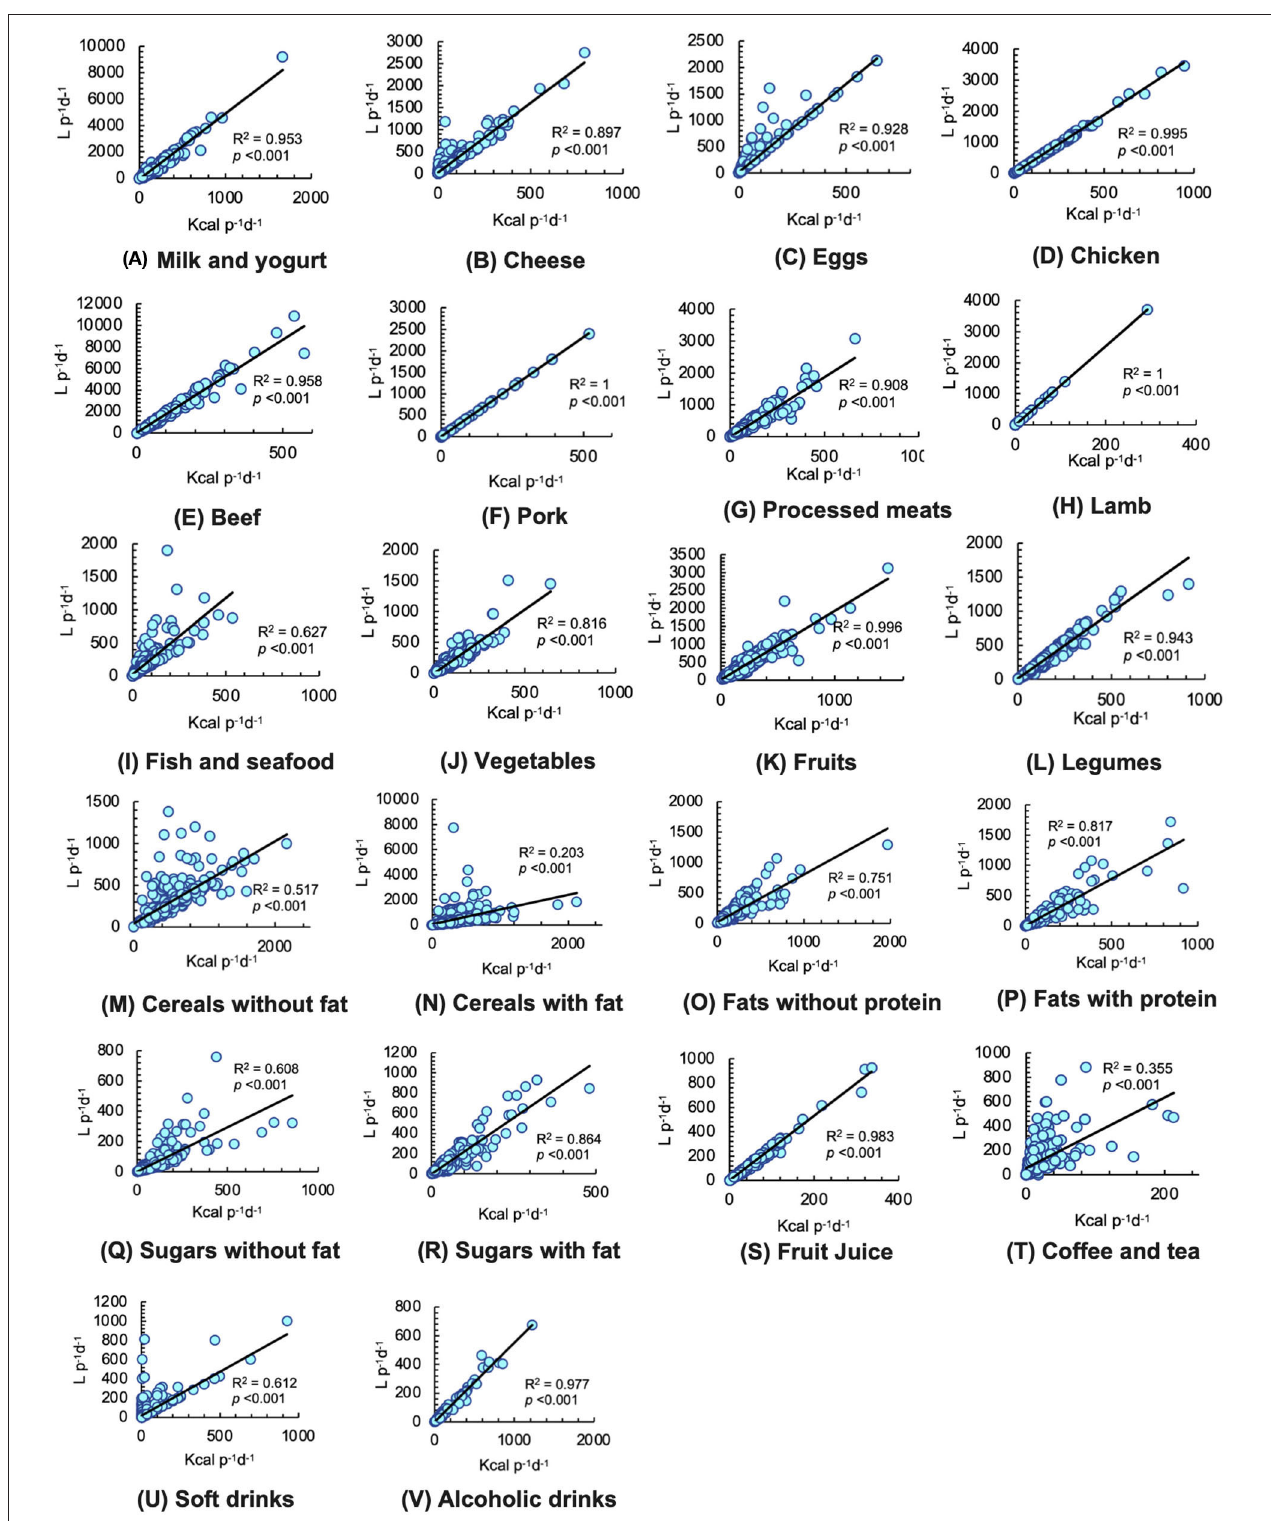
FIGURE 4 | Simple linear regressions model between caloric intake and dietary total water footprint (WF) by food groups. Statistical significance was considered at p ≤ 0.05. (A) Milk and yogurt. (B) Cheese. (C) Eggs. (D) Chicken. (E) Beef. (F) Pork. (G) Processed meats. (H) Lamb. (I) Fish and seafood. (J) Vegetables. (K) Fruits. (L) Legumes. (M) Cereals without fat. (N) Cereals with fat. (O) Fats without protein. (P) Fats with protein. (Q) Sugars without fat. (R) Sugars with fat. (S) Fruit juice. (T) Coffee and tea. (U) Soft drinks. (V) Alcoholic drinks.